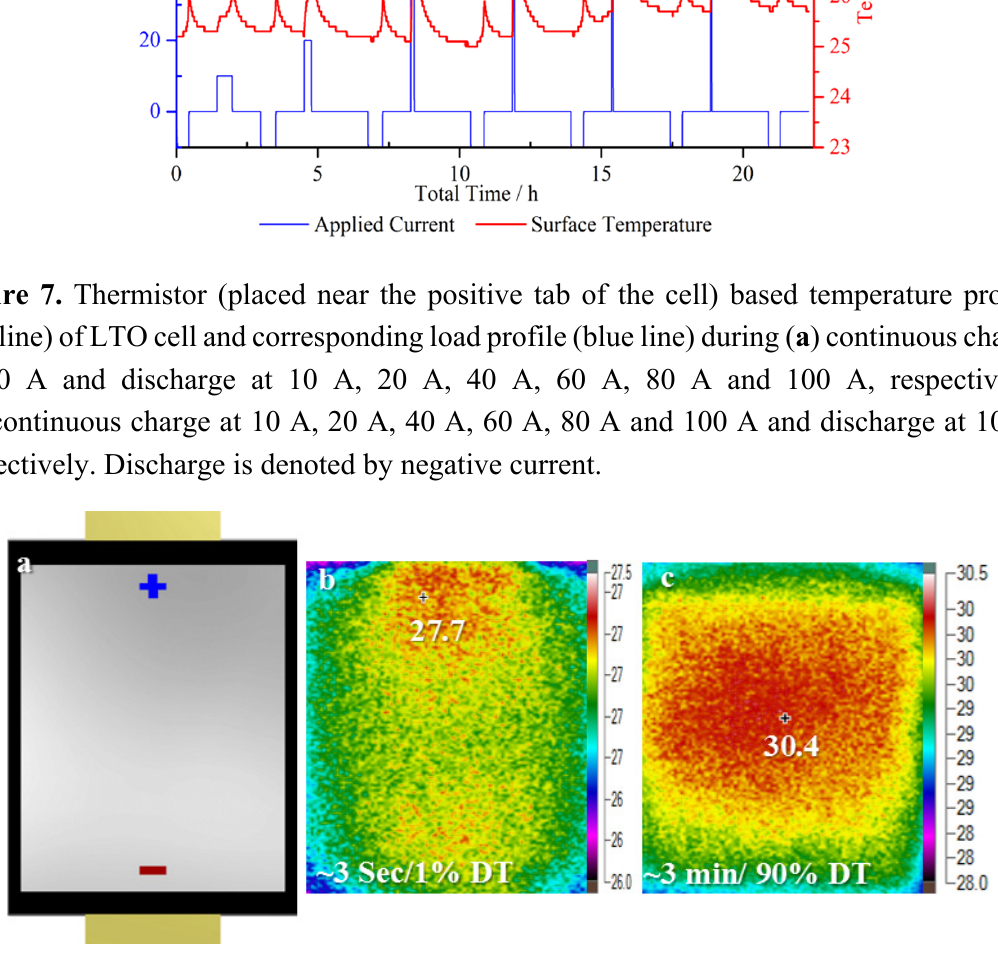
Figure 8. ( a ) Schematic of the LTO 5 Ah cell. IR images during discharge at 100 A along with the location of respective maximum temperature; ( b ) after ~3 s of discharge or ~1% of discharge time (DT); ( c ) after 3 min or ~90%